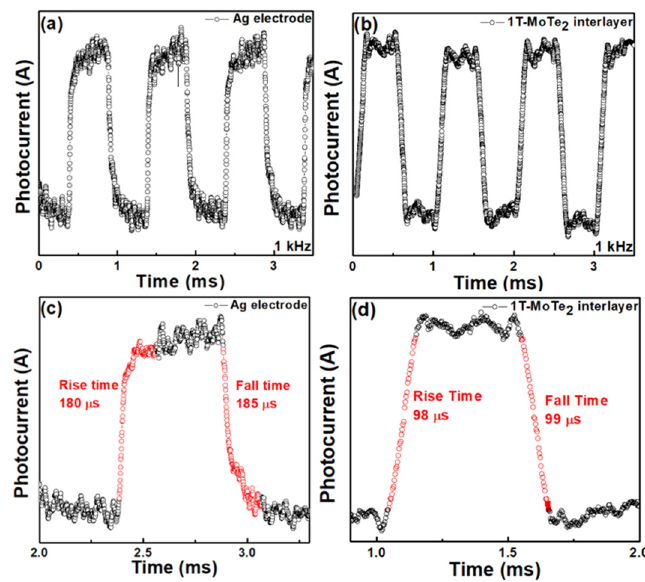
Figure 4. Time-resolved photoresponse of ( a ) Ag and ( b ) 1T-MoTe 2 interlayer electrode contacts of 2H-MoTe 2 structures at 1 kHz. The enlarged plots of ( c ) Ag and ( d ) 1T-MoTe 2 interlayer electrode contacts of 2H-MoTe 2 structures of one response cycle for calculating the rise and fall times.